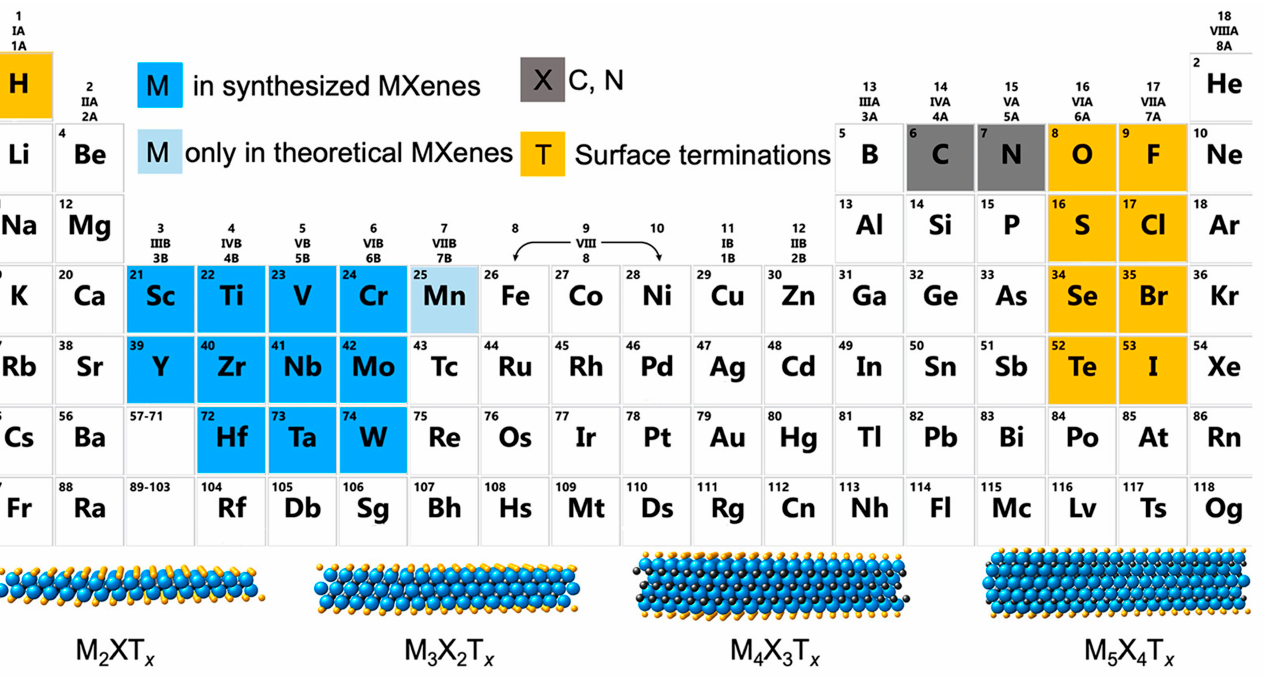
Figure 10. Periodic table presenting elements that are used in MXenes’ composition. At the bottom are illustrations of four typical MXene structures. Reprinted (adapted) with permission from [172]. Copyright 2021 American Chemical Society.